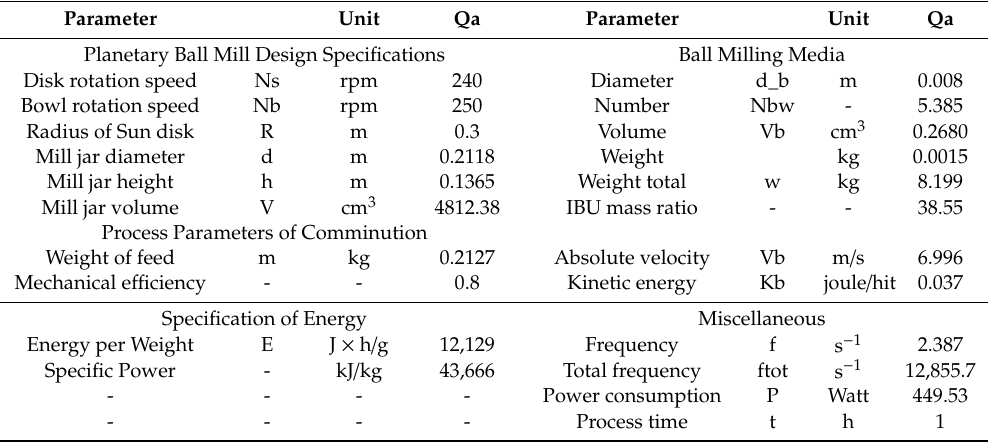
Table 10. Wet media milling equipment design specifications supporting 12 tons annual production of